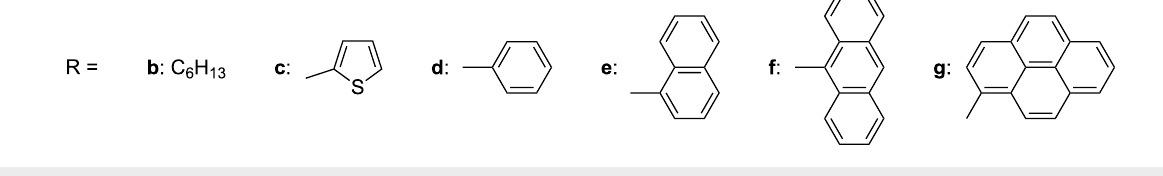
Scheme 3: Synthesis of diacyl hydrazines 14b – g